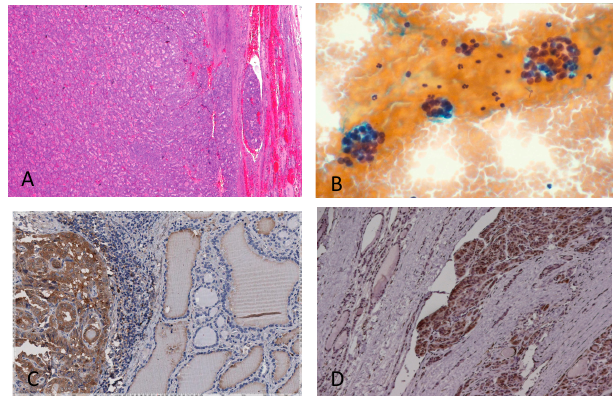
Figure 1. Follicular thyroid lesions and galectin-3 expression on histological samples. ( A ) Histological features of follicular carcinoma showing capsular and vascular infiltration. ( B ) This features cannot